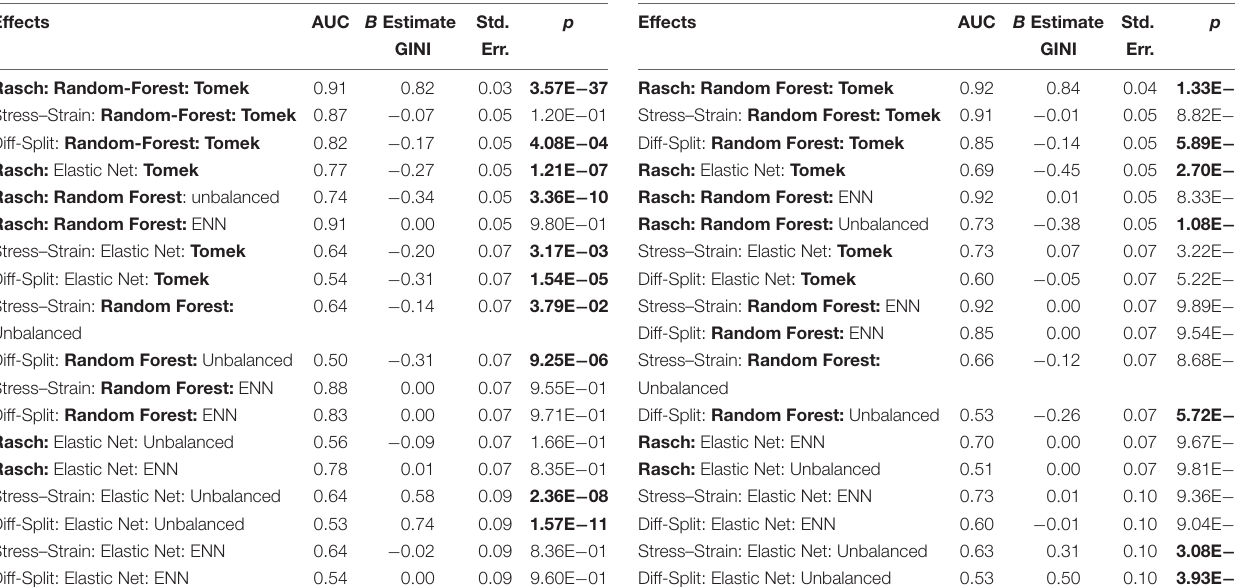
TABLE 1 | ISR cross-validation.